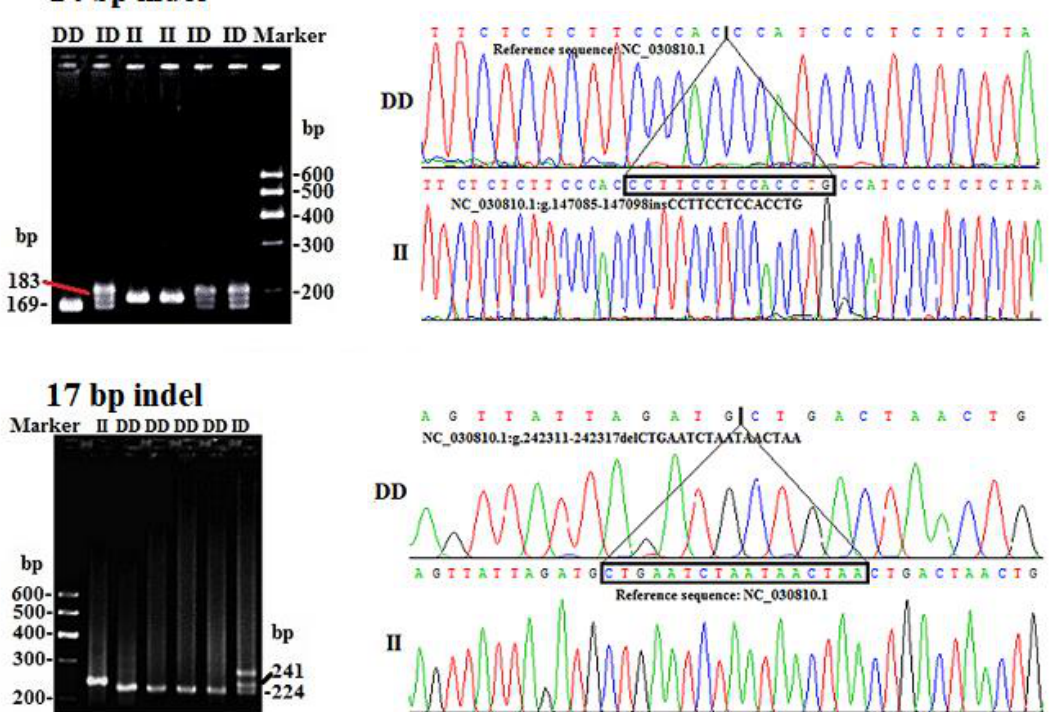
Figure 1. The sequencing map and electrophoresis pattern of 14 bp and 17 bp indel variants in goat SPAG17 gene. II, homozygote insertion genotype; DD, homozygote deletion genotype; ID, heterozygote genotype. The sequence with the black border is the difference sequence fragment. The top band in the electrophoresis pattern of ID represented heteroduplex. Marker: 600-500-400-300-200- 100 bp.